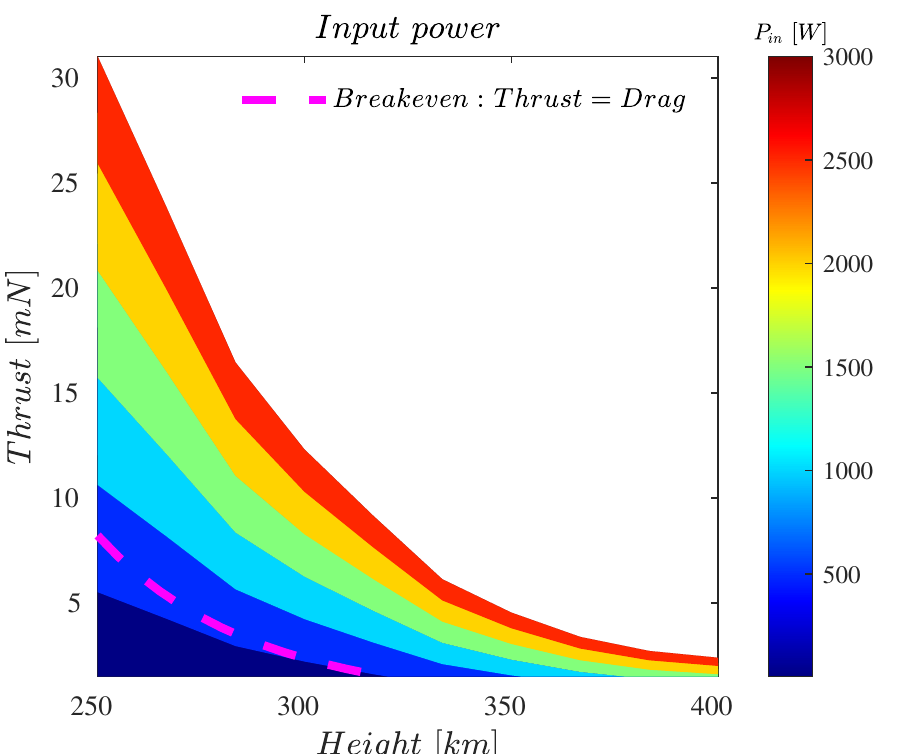
Figure 5. Available thrust at different input power levels and different orbital altitudes. The magenta dashed line represents the breakeven points where the thruster meets the drag requirement.